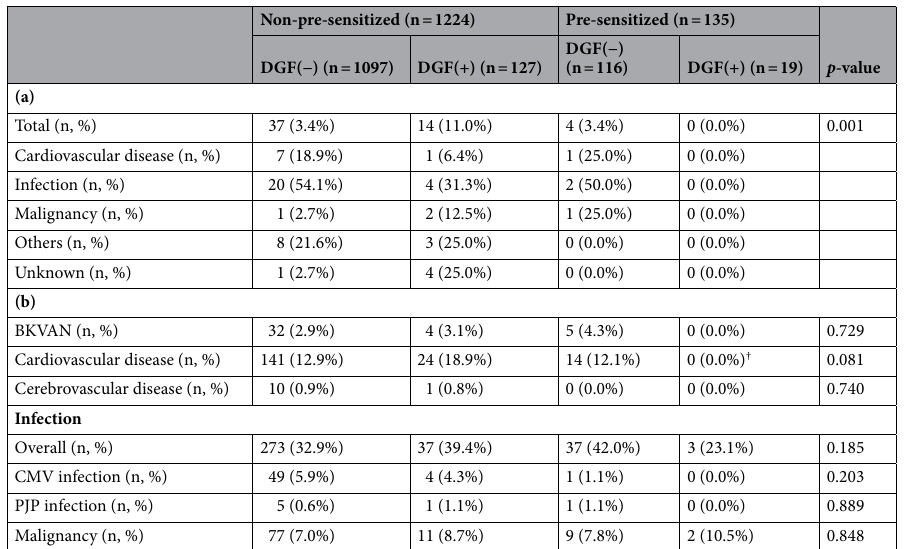
Table 4. (a) Causes of death and (b) clinical outcomes among the 4 subgroups according to DGF and pre- sensitization status. Continuous variables are shown as mean ± standard deviation or median with interquartile range. Categorical variables are shown as number (proportions). Others: liver disease, cerebral infarction, acute CNI toxicity, gastrointestinal bleeding, intestinal obstruction, acute rejection etc. DGF delayed graft